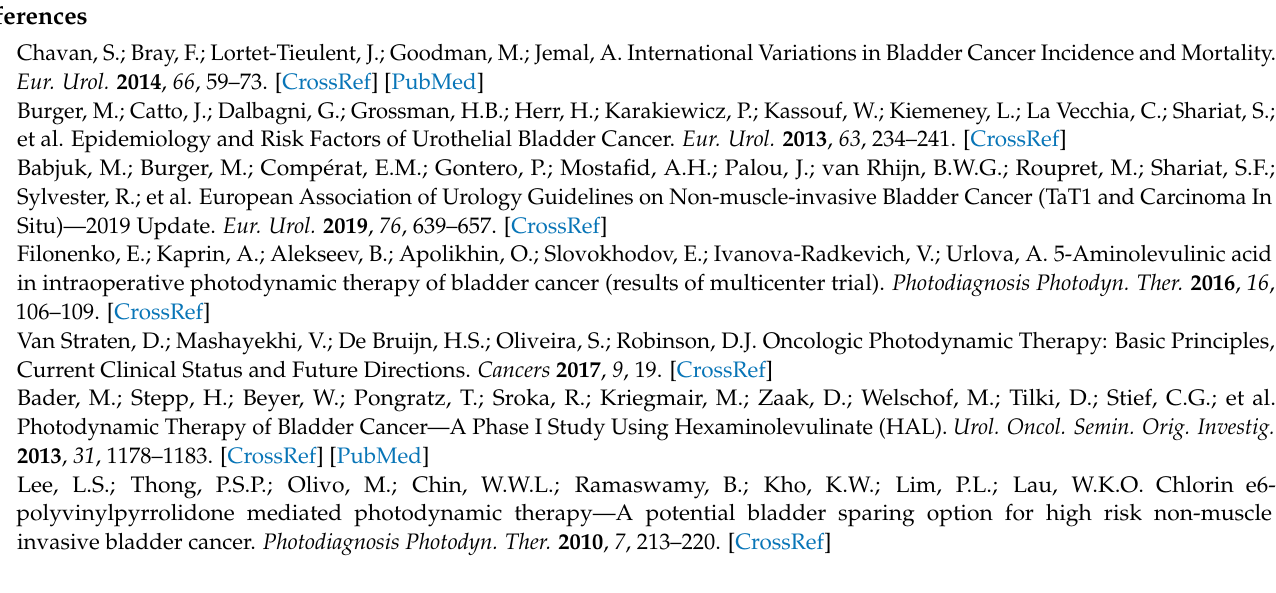
Figure S2: Molecular structures of PSs mentioned in Table 1; Figure S3: Activated “ALXT-Elomed” laser at 400 nm with a cylindrical diffuser for FD (a) and at 660 nm with a mictolens for PDT; Video S1: